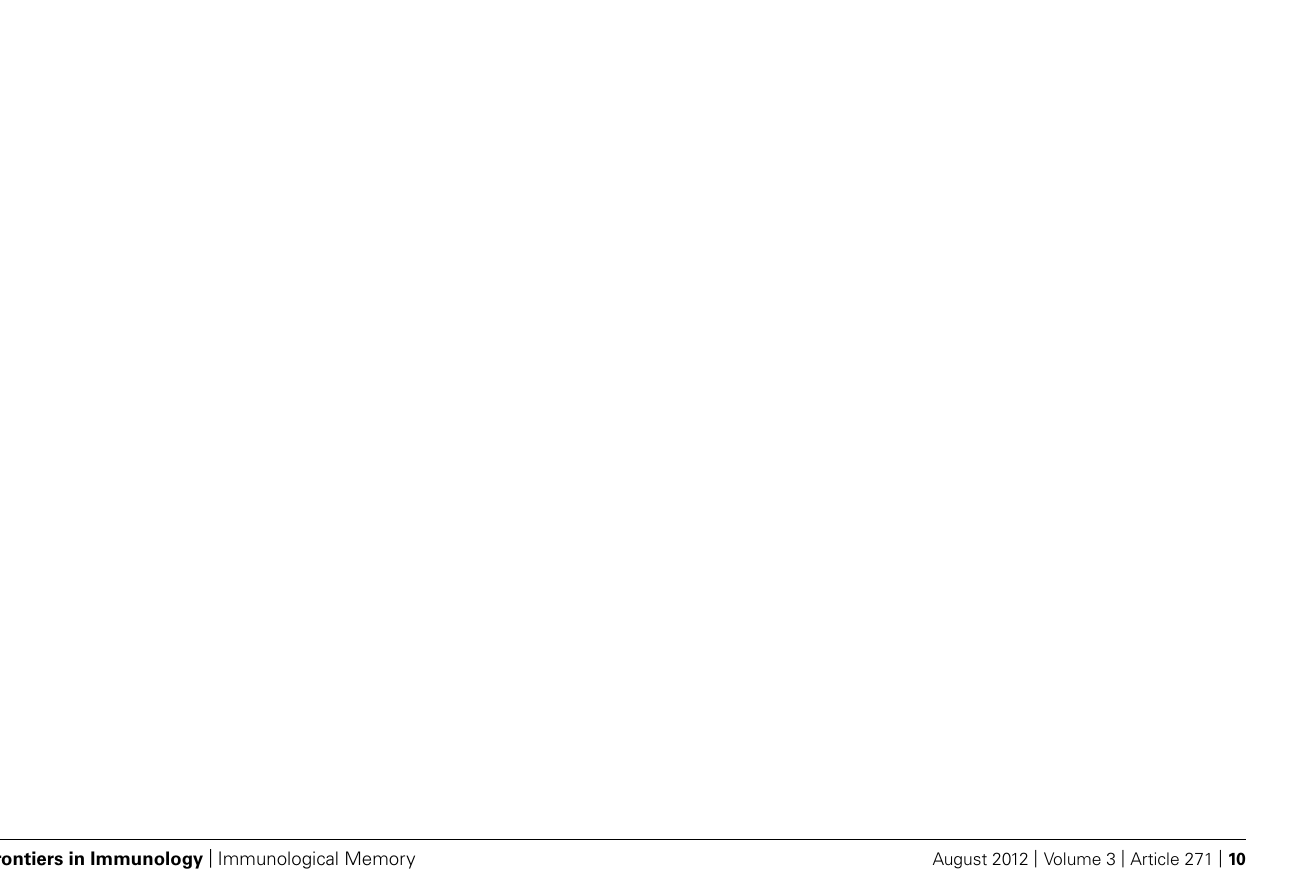
Frontiers in Immunology | Immunological